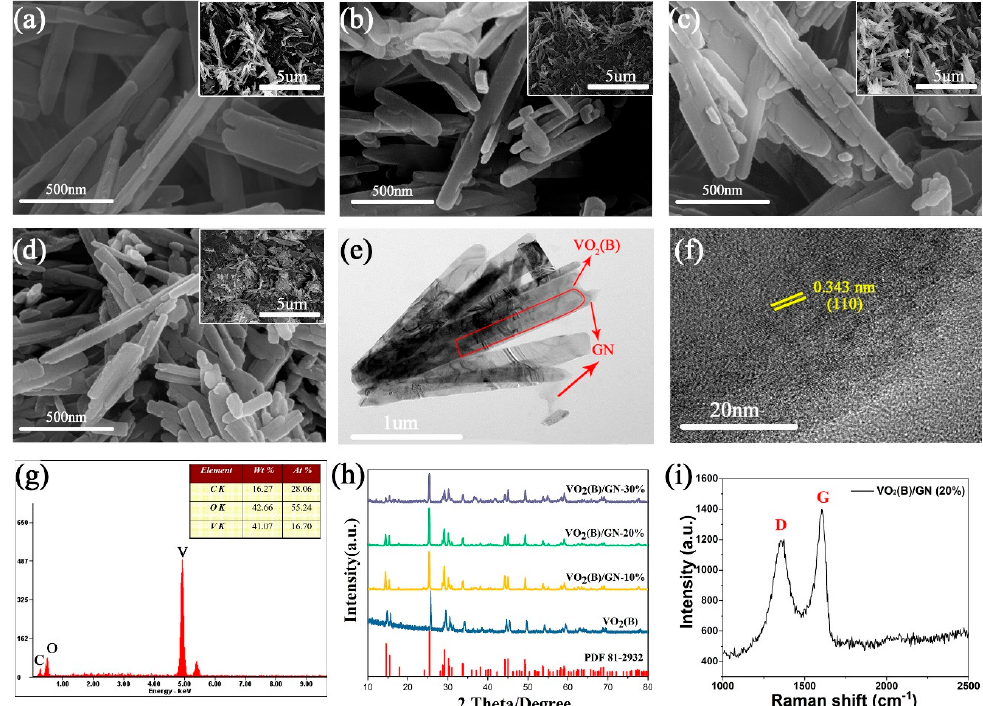
Figure 1. SEM images of ( a ) VO 2 (B), and VO 2 (B)/GN composites with different mass ratio: ( b ) 10%, ( c ) 20%, ( d ) 30%, ( e ) TEM image and ( f ) HRTEM images of VO 2 (B)/GN composites, ( g ) EDX image of VO 2 (B)/GN composites, ( h ) XRD patterns of VO 2 (B) and VO 2 (B)/GN composites, and ( i ) Raman spectrum of VO 2 (B)/GN (20%).